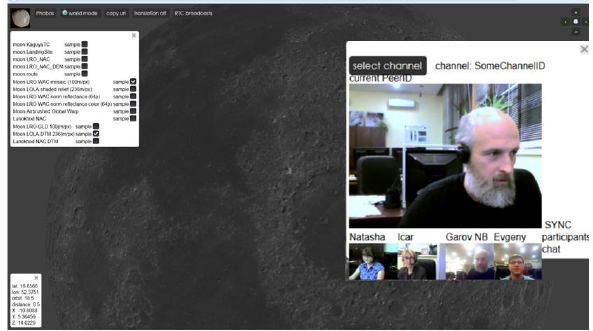
Figure 1. Online communication within a single software environment based on joint user three-dimensional spatial